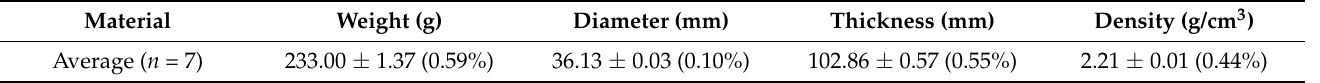
Table 10. Main physical results of tested pieces extracted from concrete blocks provided by DVTec (C-DVTec). Material